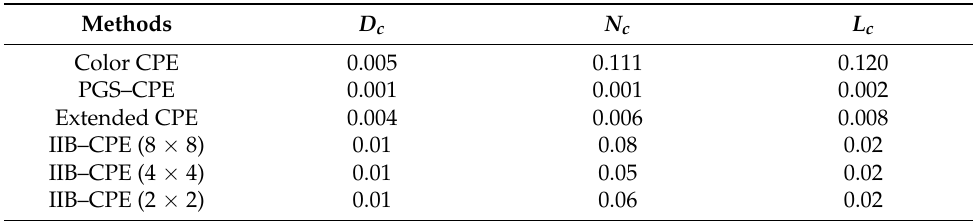
Table 8. The CPE schemes robustness analysis against the JPS